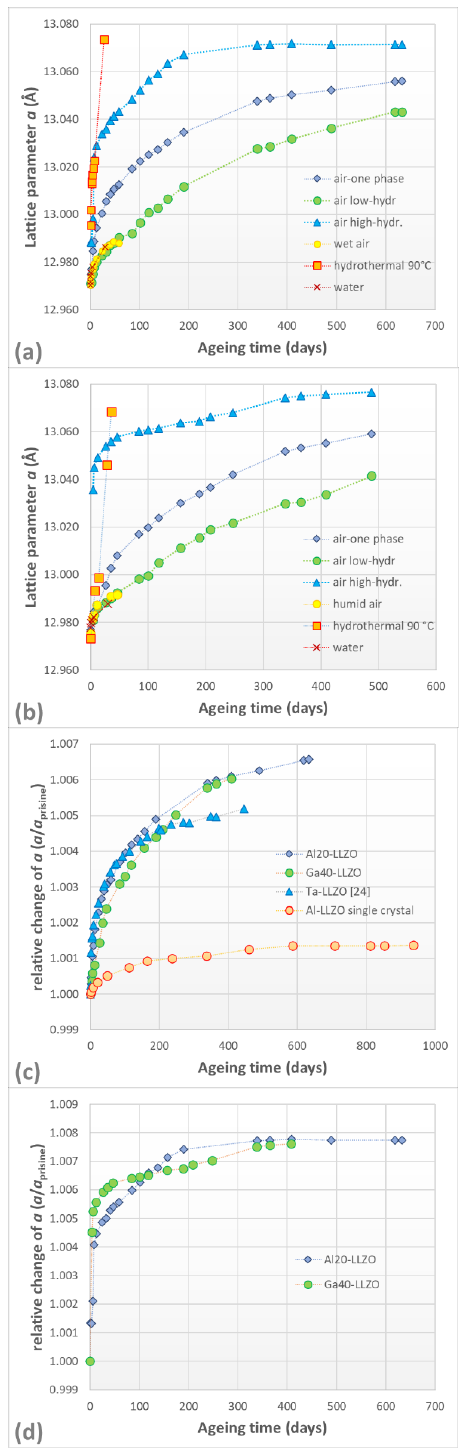
Figure 3. Variation in lattice parameters of ( a ) Al10-LLZO and ( b ) Ga40-LLZO under different aging conditions as a function of time (aging) in days. ( c ) Comparison of the relative changes in lattice parameters during aging in air with a one-garnet model. Data for Li 6 La 3 ZrTaO 12 from [24] are also included for comparison. ( d ) Relative changes in the highly hydrated surface material. Estimated standard deviations/error bars are smaller than the symbols.